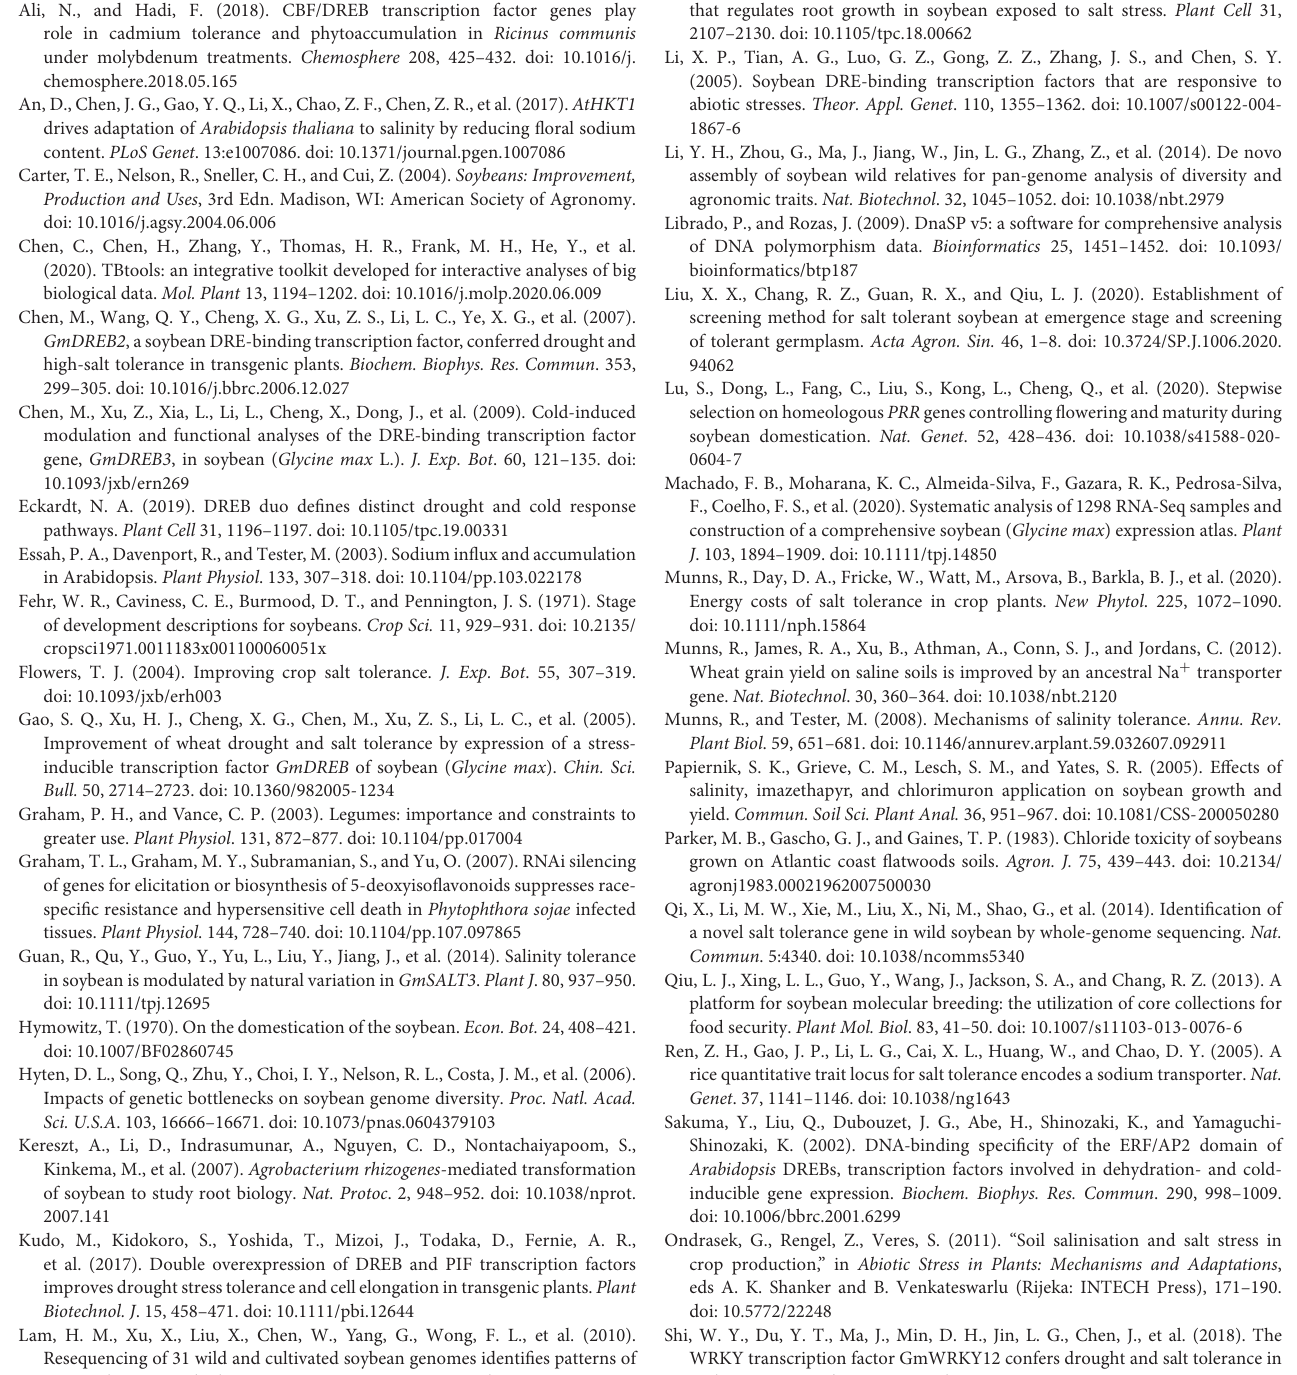
Supplementary Figure 11 | Selective sweep in the DREB3a genomic region. Supplementary Figure 12 | Development of functional genetic markers for DREB3b Ref and DREB3b 39 Del alleles. Lines 1–7, soybean plants